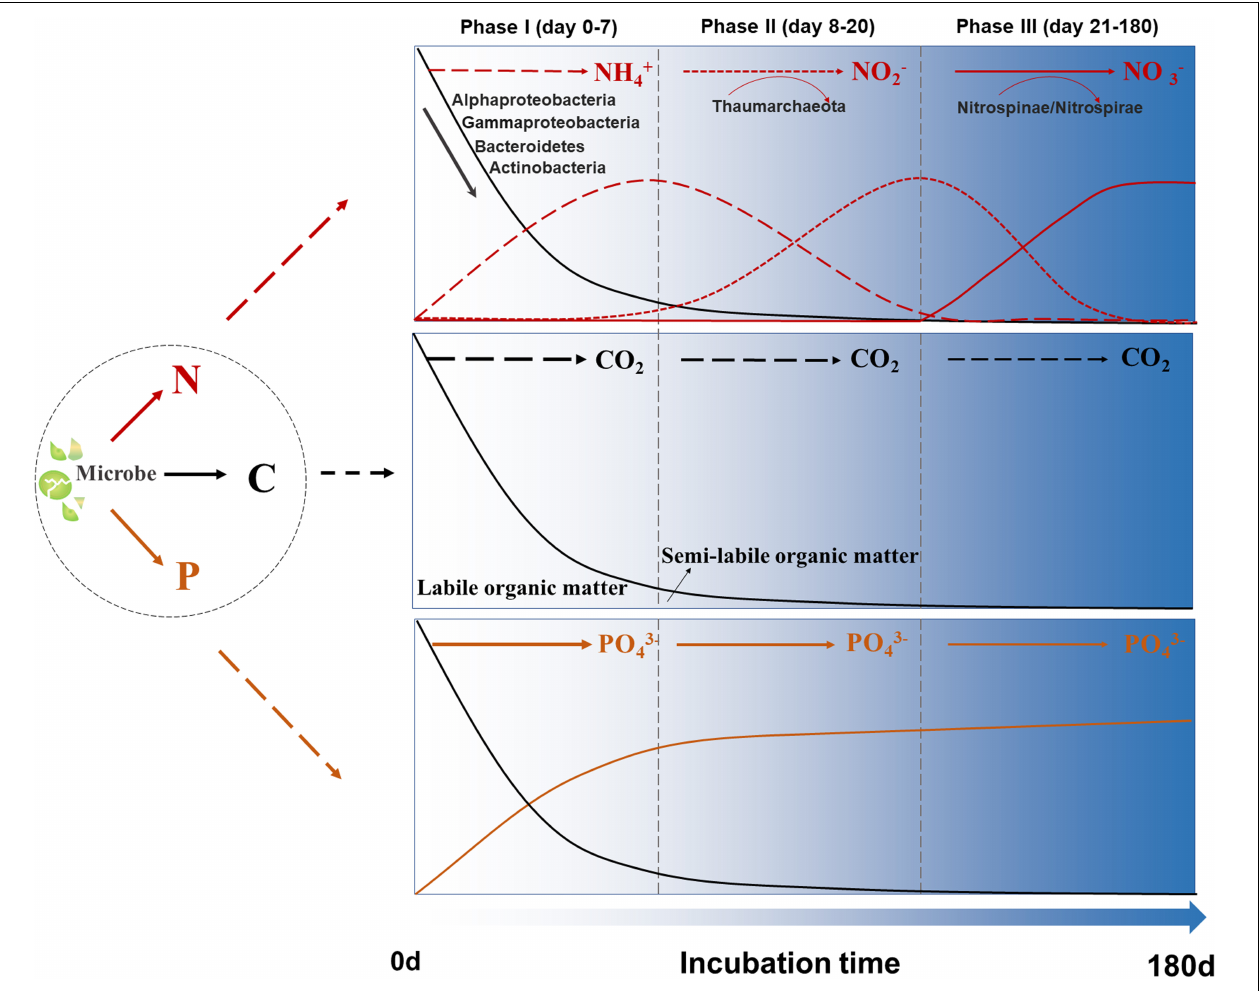
FIGURE 6 | Schematic illustration of C, N, and P coupling in our 180-day incubation system. Black lines: the variations of total organic carbon concentrations; Red lines: the transformation of three forms of inorganic N; Orange lines: the variations of phosphate